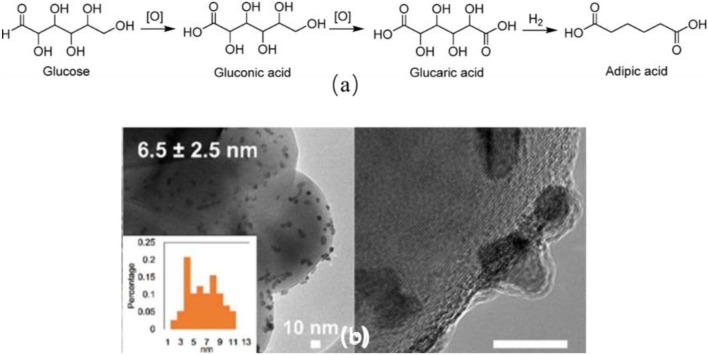
(A) Glucose oxidation to produce AA, (Jin et al., 2016). (B) TEM images of PtPd/TiO2 (Jin et al., 2016).